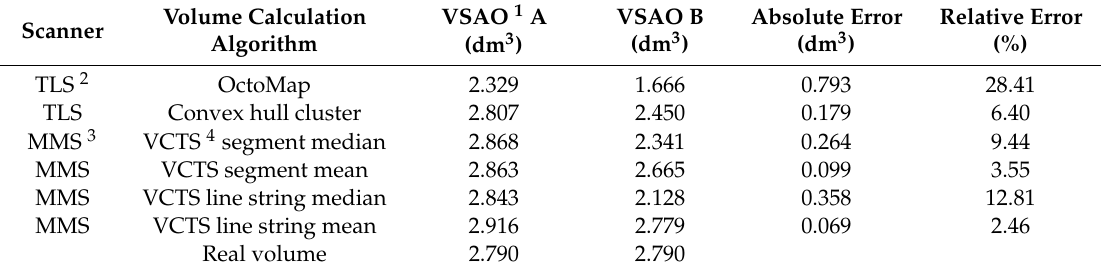
Table 10. Volume calculation results and errors